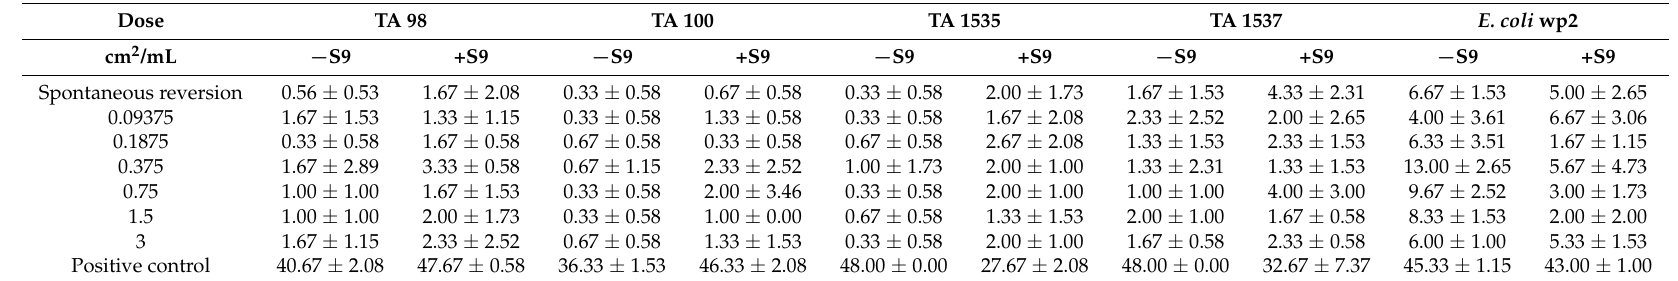
Table 10. Number of positive cells in Ames test of PLGA/PHB +